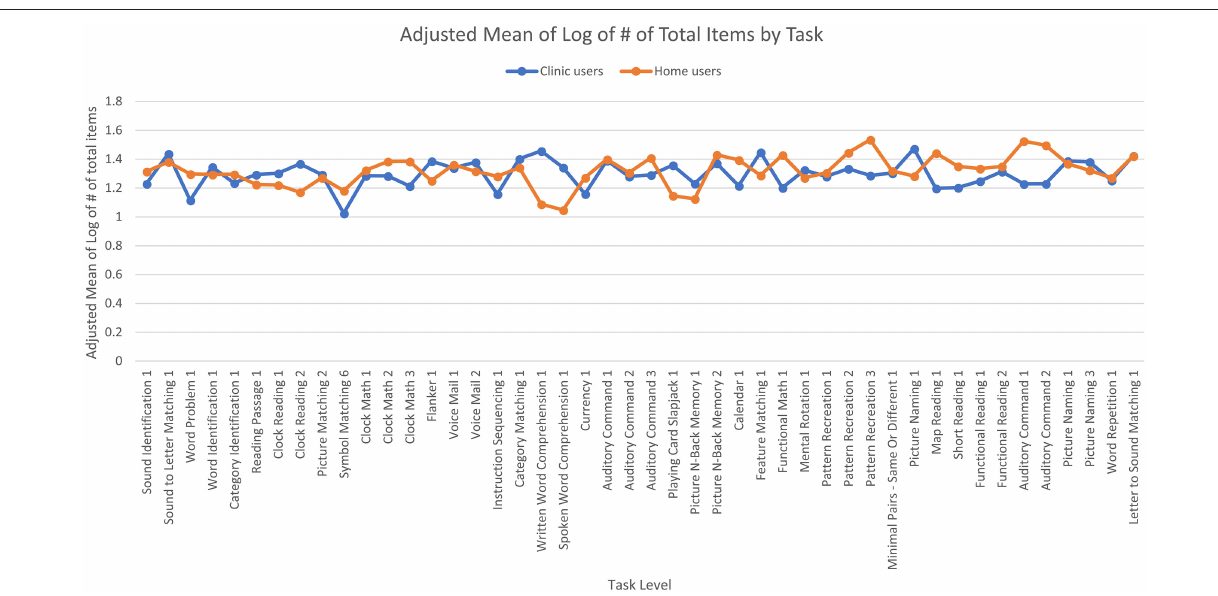
FIGURE 6 | Adjusted means for the total number of therapy items the users completed by user group. Covariates appearing in the model are evaluated at the following values: years since injury = 2.10, age =